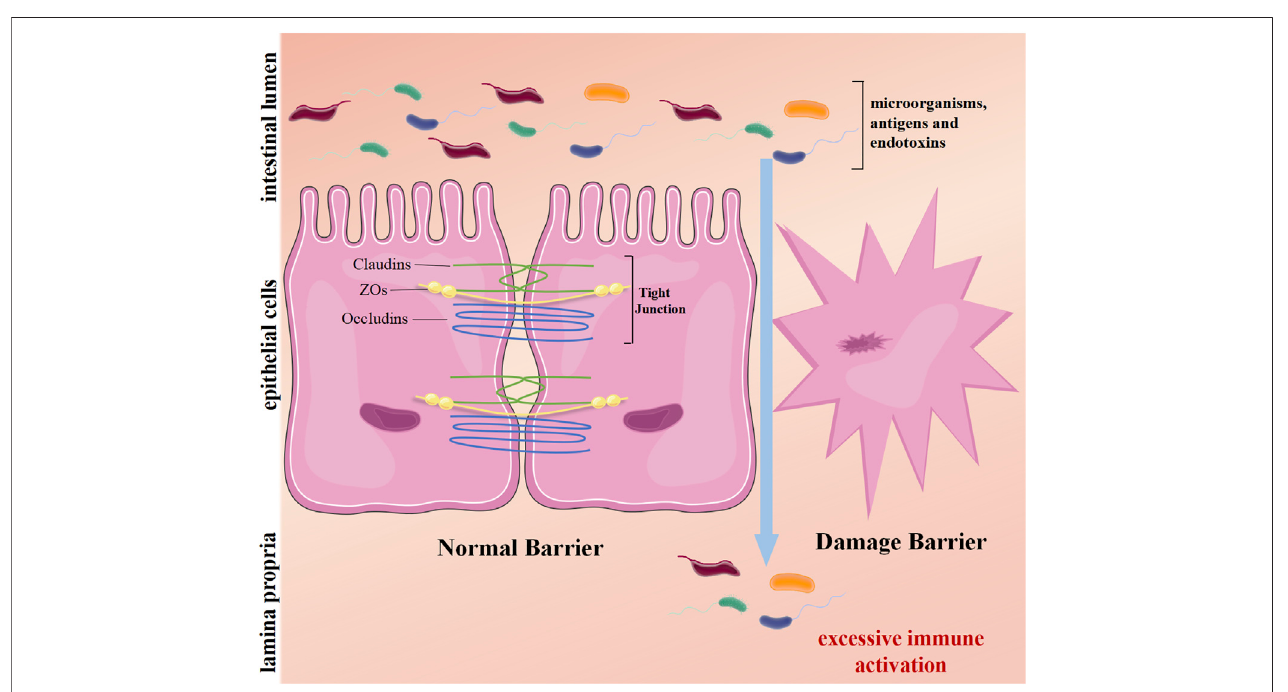
FIGURE 1 | The mechanical barrier of the intestine. The intestinal epithelial cells and their tight junctions (TJs) form a physical barrier. TJs mainly consist of transmembrane proteins: occludins, claudins, and zonula occludens (ZOs). On average, harmful substances in the lumen cannot penetrate the epithelium. However, damage barriers allow toxic molecules to pass, induce in fl ammation, and excessive immune activation, causing intestinal